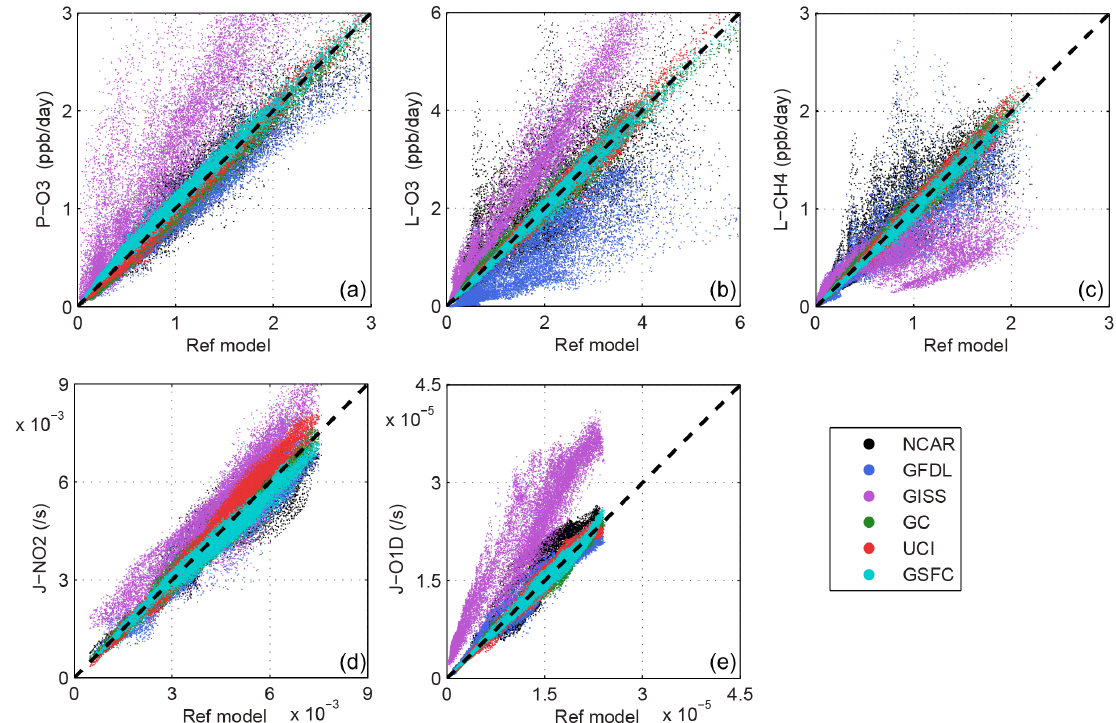
Figure 3. Direct parcel by parcel comparison of modeled reactivities ( a , P -O3; b , L -O3; c , L -CH4; all ppbday − 1 ) and photolysis rates ( d , J -NO2; e , J -O1D; all s − 1 ) calculated for the 14880 simulated air parcels. Each point is an average over the five simulated dates in August (01/8, 06/8, 11/8, 16/8, 21/8). The 1 : 1 line is shown (black dashed) for each plot. The reference values ( x axis) are the average of three similar models (GSFC, GC, UCI) selected by examining the rms differences across all the models (see text). For this plot alone, models are plotted in the following order with the most disperse points being first for visibility: NCAR, GFDL, GISS, GC, UCI. GSFC. The model colors throughout this paper are consistent, but the order of plotting is shown in the